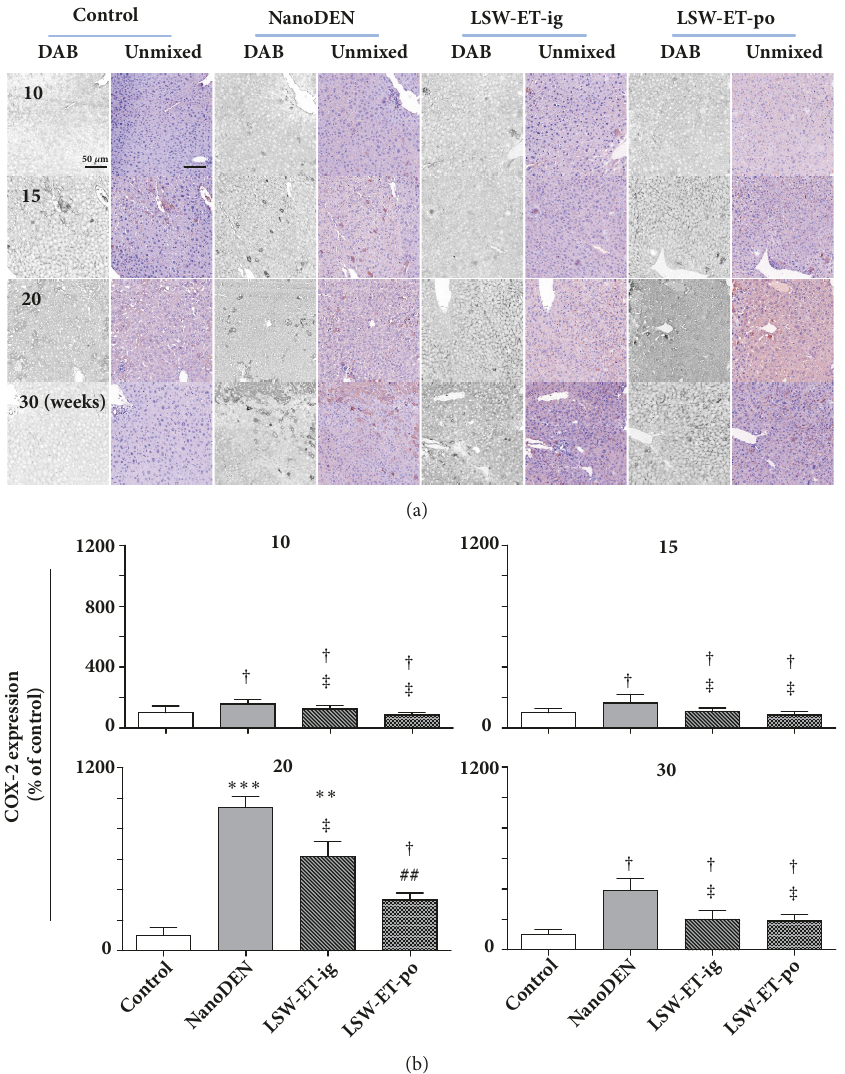
Figure 4: Oral application of L S W-ET decreased the nano D EN-induced COX-2 expression in mice. (a) Expression of COX-2 by immunohistochemistry. Scale bar, 50 휇 m. (b) Quantitative expression of COX-2 determined by immunohistochemistry. (Results were expressed as the mean ± SEM. ∗ , P < 0.05; ∗∗ , P < 0.01; ∗ ∗ ∗ , P < 0.001; † , P > 0.01, compared with the control group. #, P < 0.05; ##, P < 0.01; ###, P < 0.001; ‡ , P > 0.01, respectively, compared with the nanoDEN